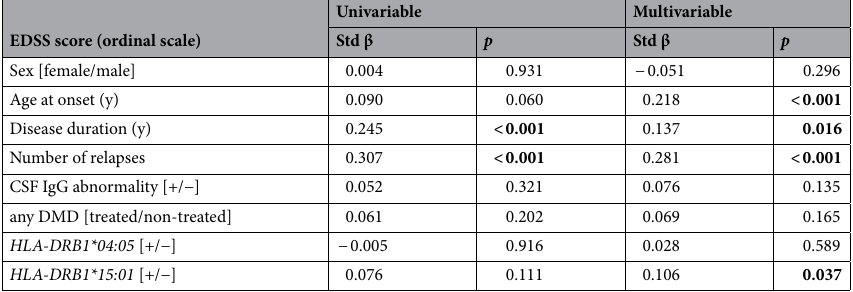
Table 8. Clinical and genetic factors associated with EDSS scores in RRMS. Bold values indicate significant correlations. CSF cerebrospinal fluid, DMD disease modifying drug, EDSS expanded disability status scale, RRMS relapsing–remitting multiple sclerosis, Std standardized, y